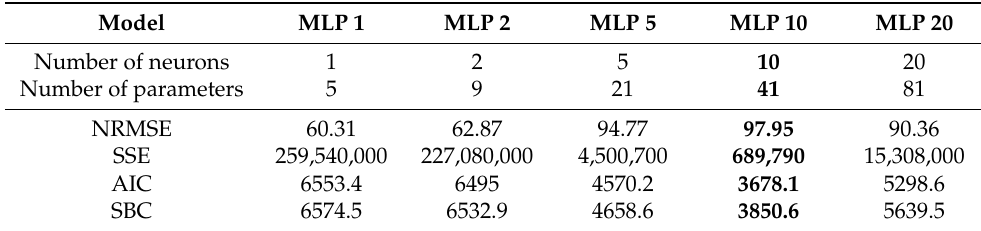
Table 5. Overview of the parameters of the created MLP models and performance metrics of the DMSP-40 muscle validation results.